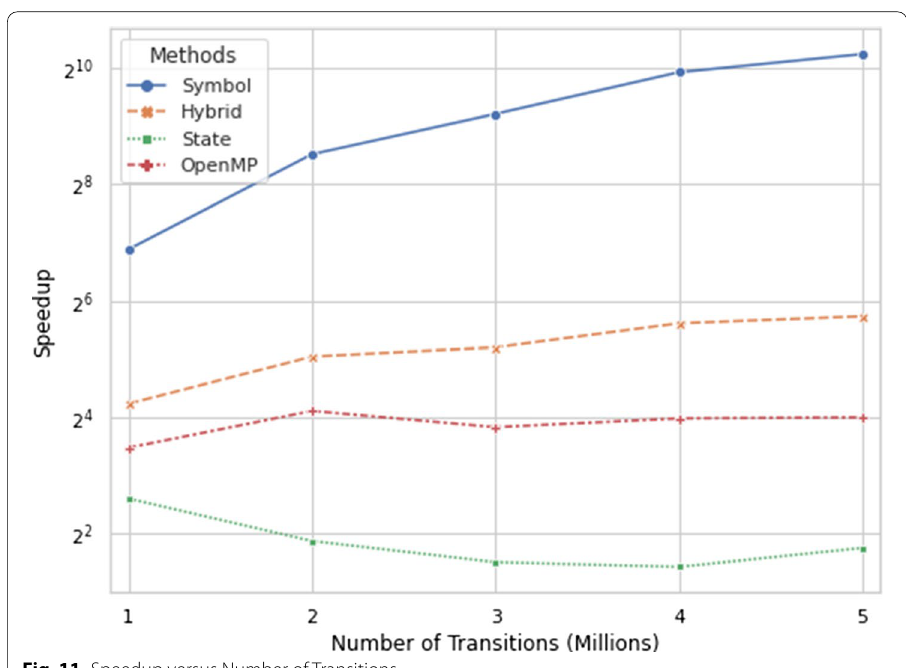
Fig. 11 Speedup versus Number of Transitions